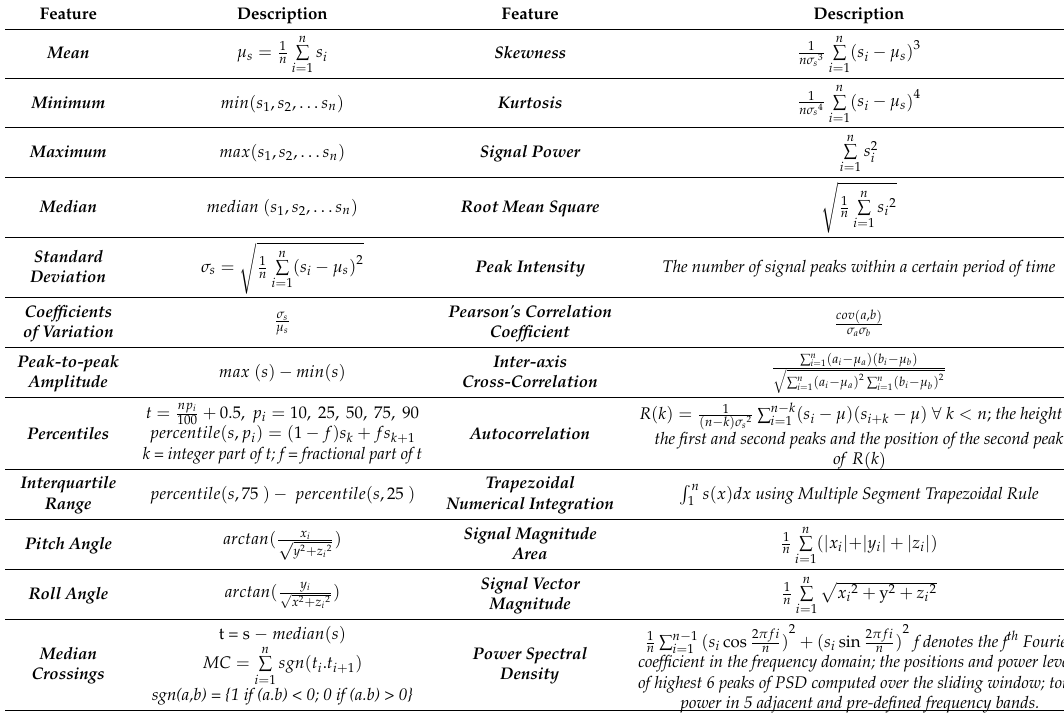
Table 1. The features